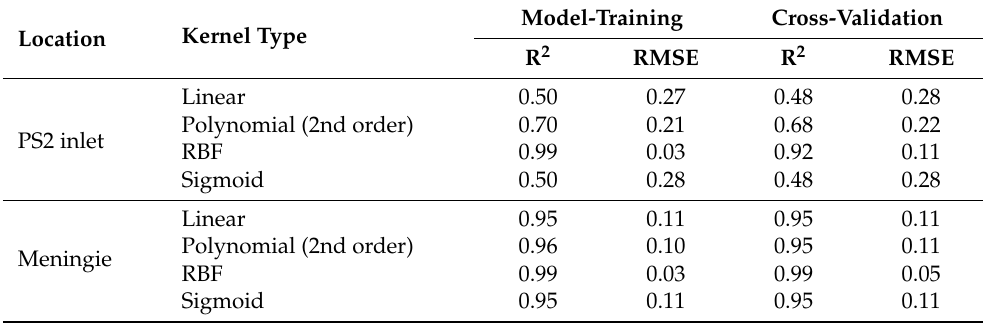
Table 1. SVR model’s performance under different kernel functions at the PS2 inlet and Meningie.